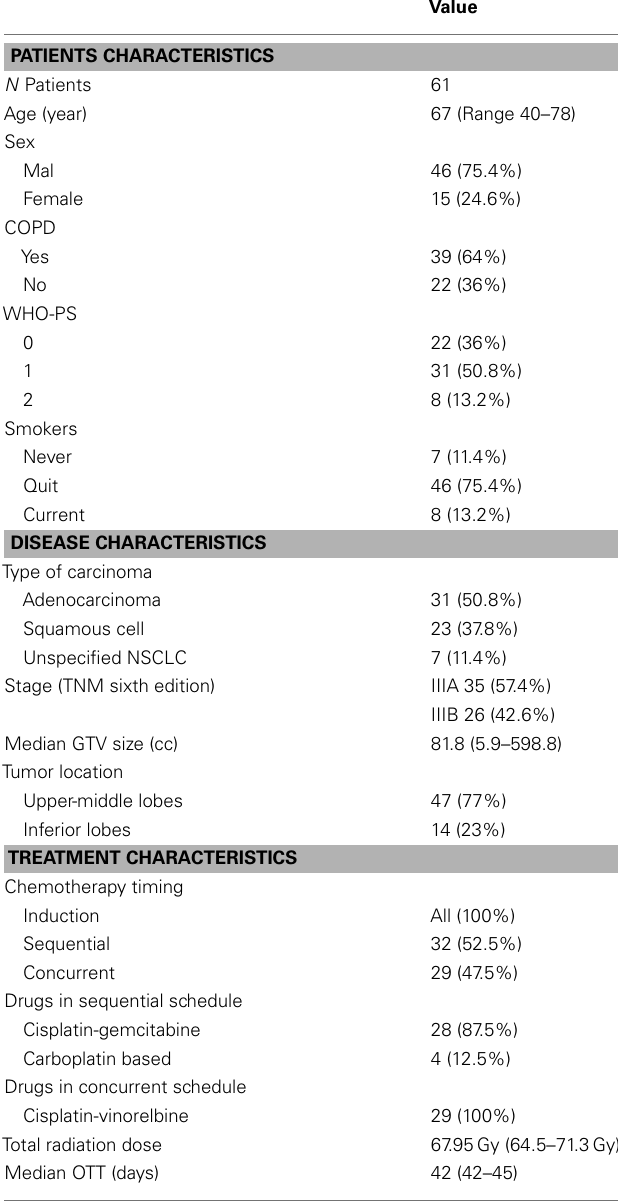
Table 1 | Baseline